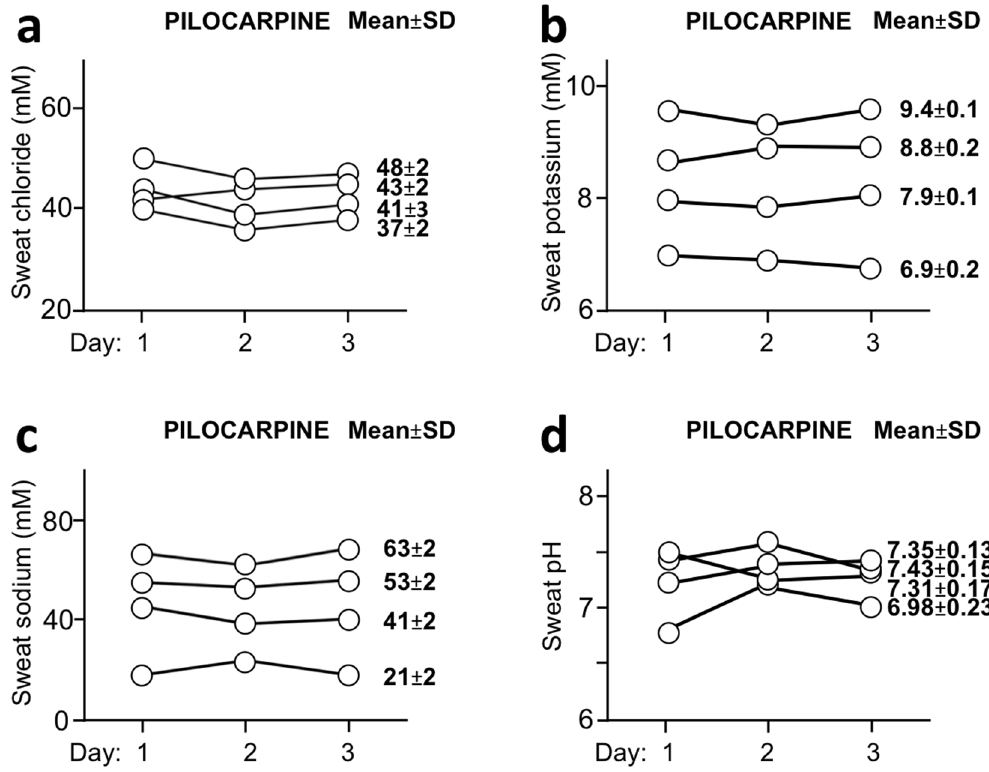
Figure 4. Measurement repeatability of various parameters in sweat produced following pilocarpine iontophoresis. We investigated the measurement repeatability of various parameters by measuring electrolyte levels or pH in 4 healthy subjects for 3 days at 24hr-interval (level of chloride: ( a ), potassium: ( b ), sodium: ( c ); pH: ( d )). Mean ± SD data corresponding to the values obtained for 3 days for a given subject are